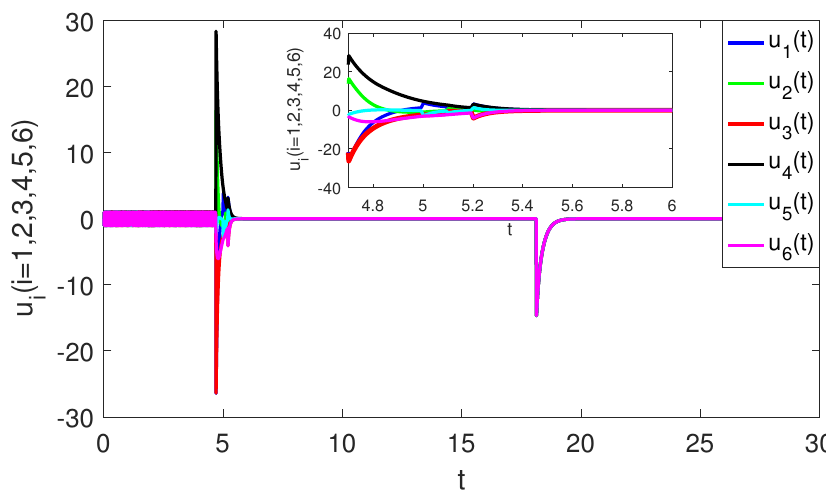
Figure 8. The evolution of control input u i ( t ) for i = 1,2, · · · ,6.